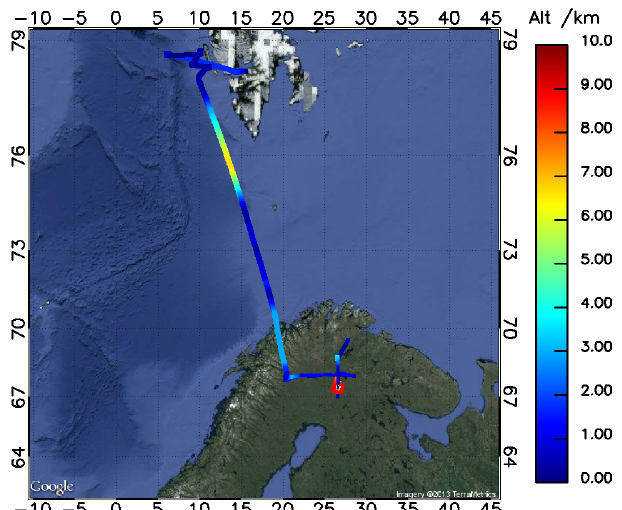
Figure 3. Flight track of FAAM flights B719 (thick track) and B720 (thin track) on 17 July and 18 July 2012, respectively, colour coded for altitude as indicated in the legend. Permission granted by Google Maps and TerraMetrics, Inc to display the imagery shown here.